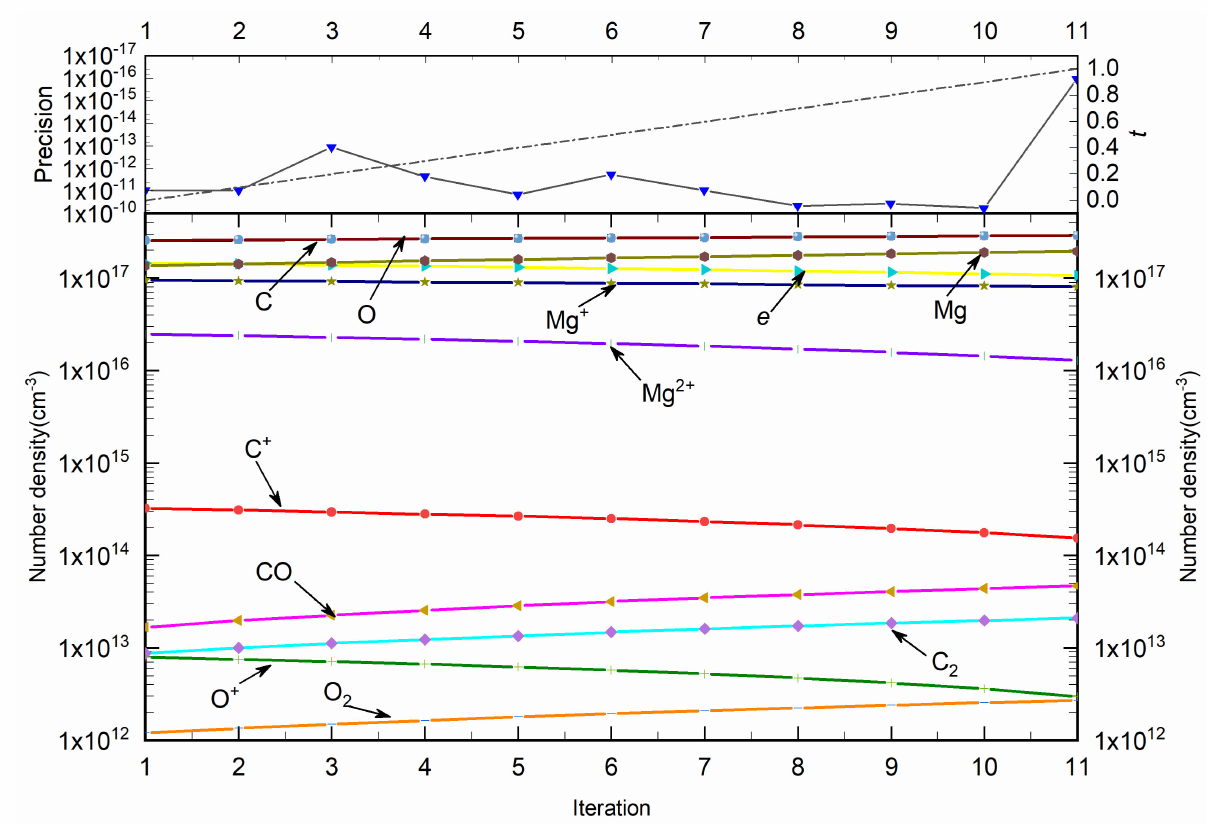
Figure 2. Variations in the control parameter, the precision, and the number density of each particle with the iteration for the Mg50%-CO50% mixture